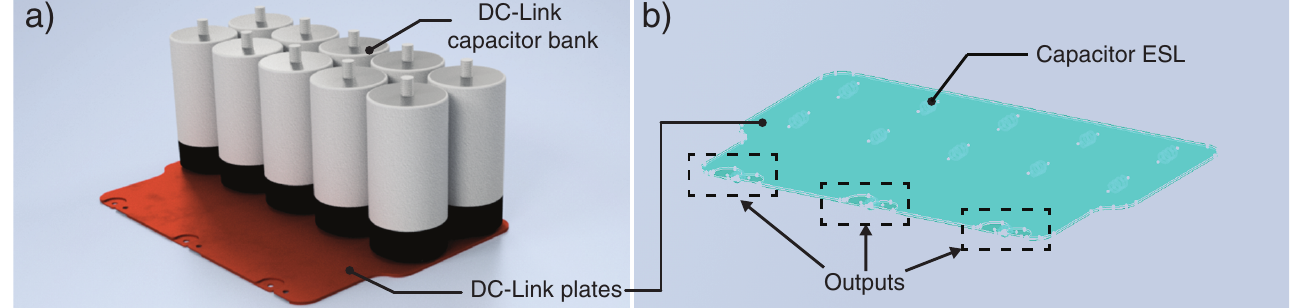
Figure 7. ( a ) Designed 3D model of the DC-Link capacitor bank including copper plates. ( b ) 3D parasitic stray inductance analysis, performed from the output module connections by using Altair Flux 2018.